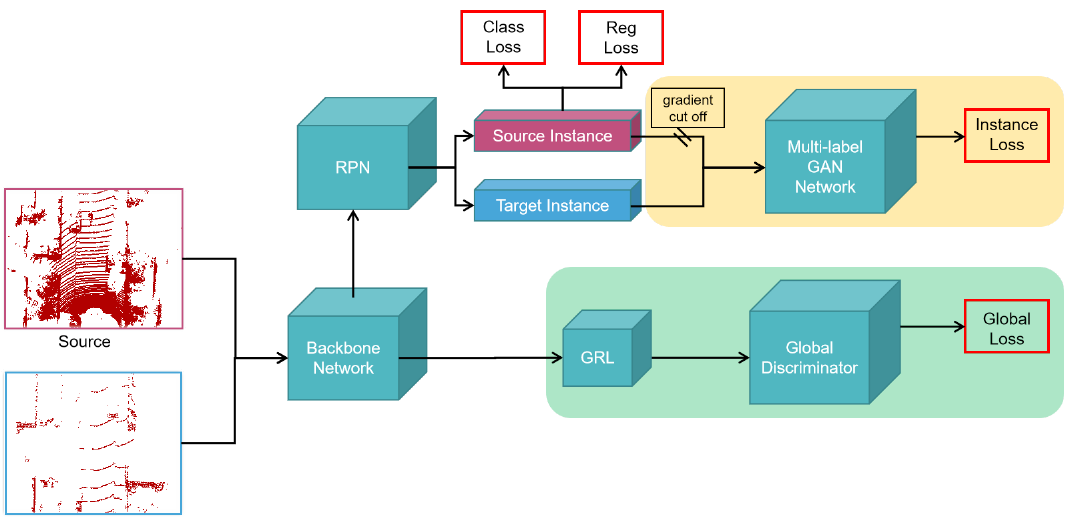
Figure 1. An overview of our subcategory domain adaptive network: We perform model adaptation from two aspects, the global features and subcategory instance features. Both are trained by generative adversarial rules. Different domain data extract features through the same backbone network and an region proposal network (RPN) is used to extract instance features. The instance discriminator is designed as a multi-label generative adversarial network (GAN) network for subcategory